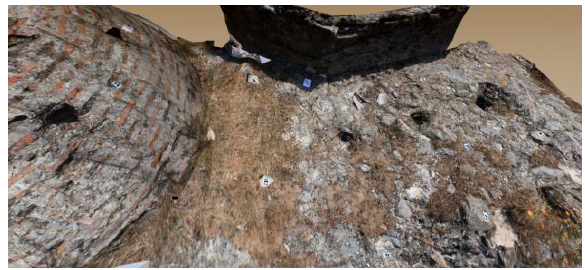
Figure 20. Detailed part of North West in